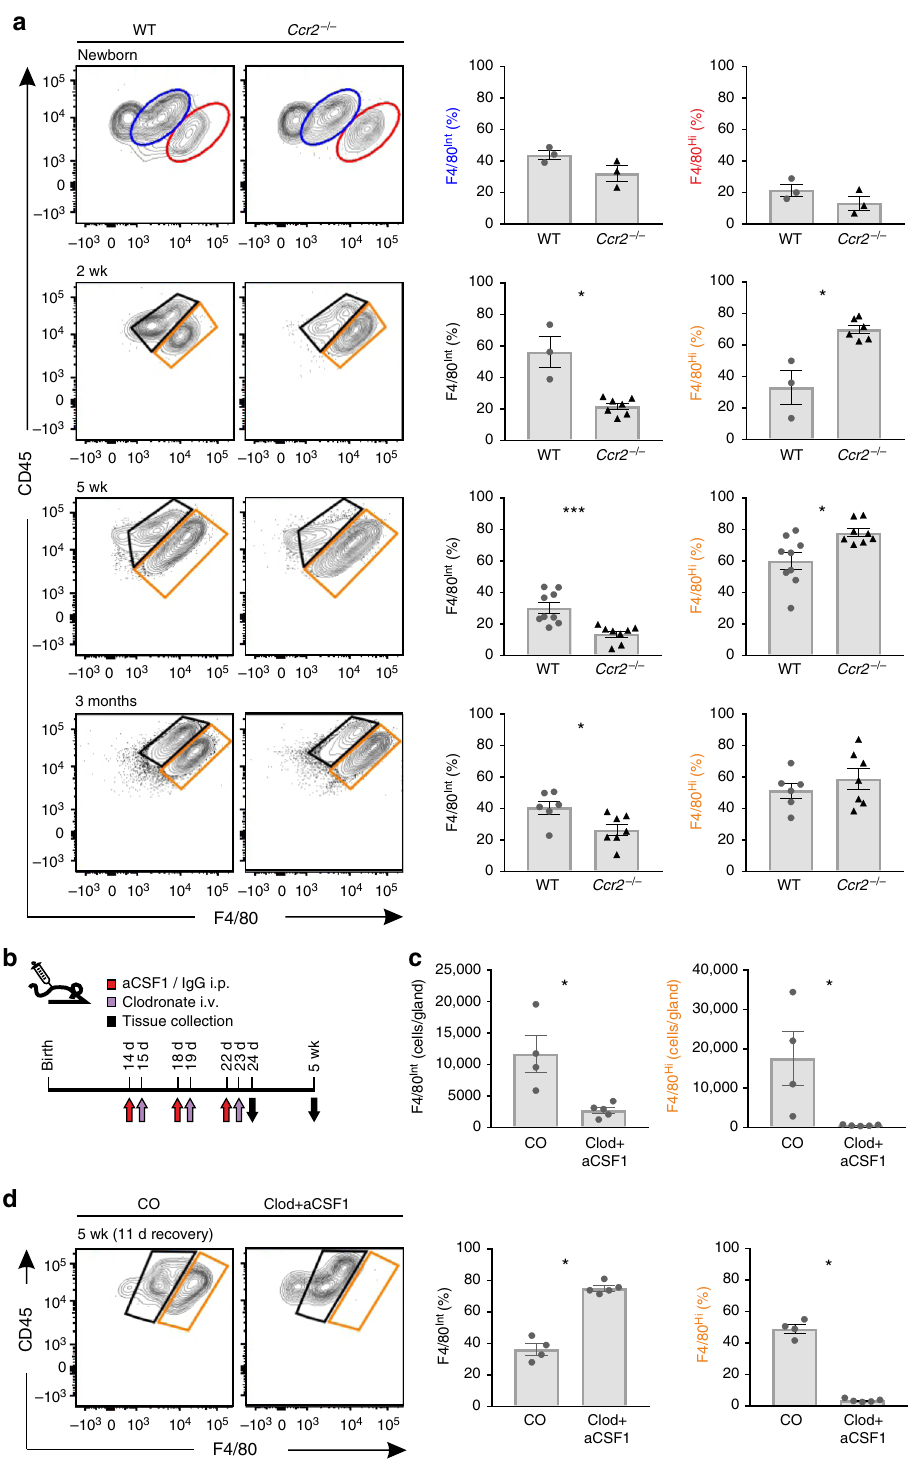
thus suggest that the fetal-derived tissue-resident macrophages in the MG are de fi ned as F4/80 Hi CD64 Hi Siglec-1 Hi CD206 Hi